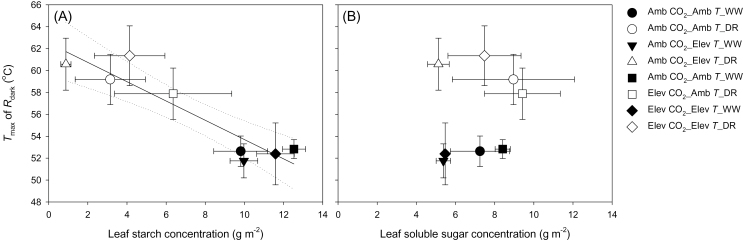
Relationship between temperature where R
dark reached its maximum (T
max) and (A) leaf starch and (B) soluble sugar concentrations (g m–2) of Eucalyptus globulus with values of T
max taken from Fig. 3 and starch/sugar concentrations from Table 1. Values shown are the mean of three replicates (±SE). Analyses of starch and sugar were carried out on a different set of (unheated) leaves from those used for the R
dark–T measurements. In (A), linear regression revealed a significant negative relationship (P<0.001; r
2=0.82) between T
max and starch concentration (regression shown with a solid line, with dotted lines showing 95% confidence intervals). In contrast, there was no significant relationship between T
max and concentration of soluble sugars (B). See Table 1 for treatment means of sugar and starch concentrations.